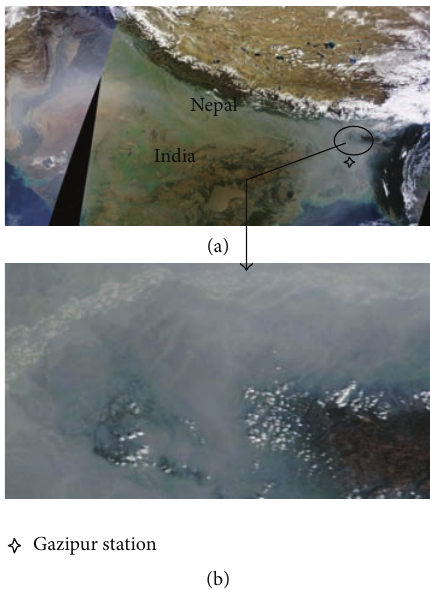
Figure 9: (a) Satellite image captured on 12 December 2013 by MODIS aboard Terra on South Asia and (b) zoomed-in version of the circled area in the figure